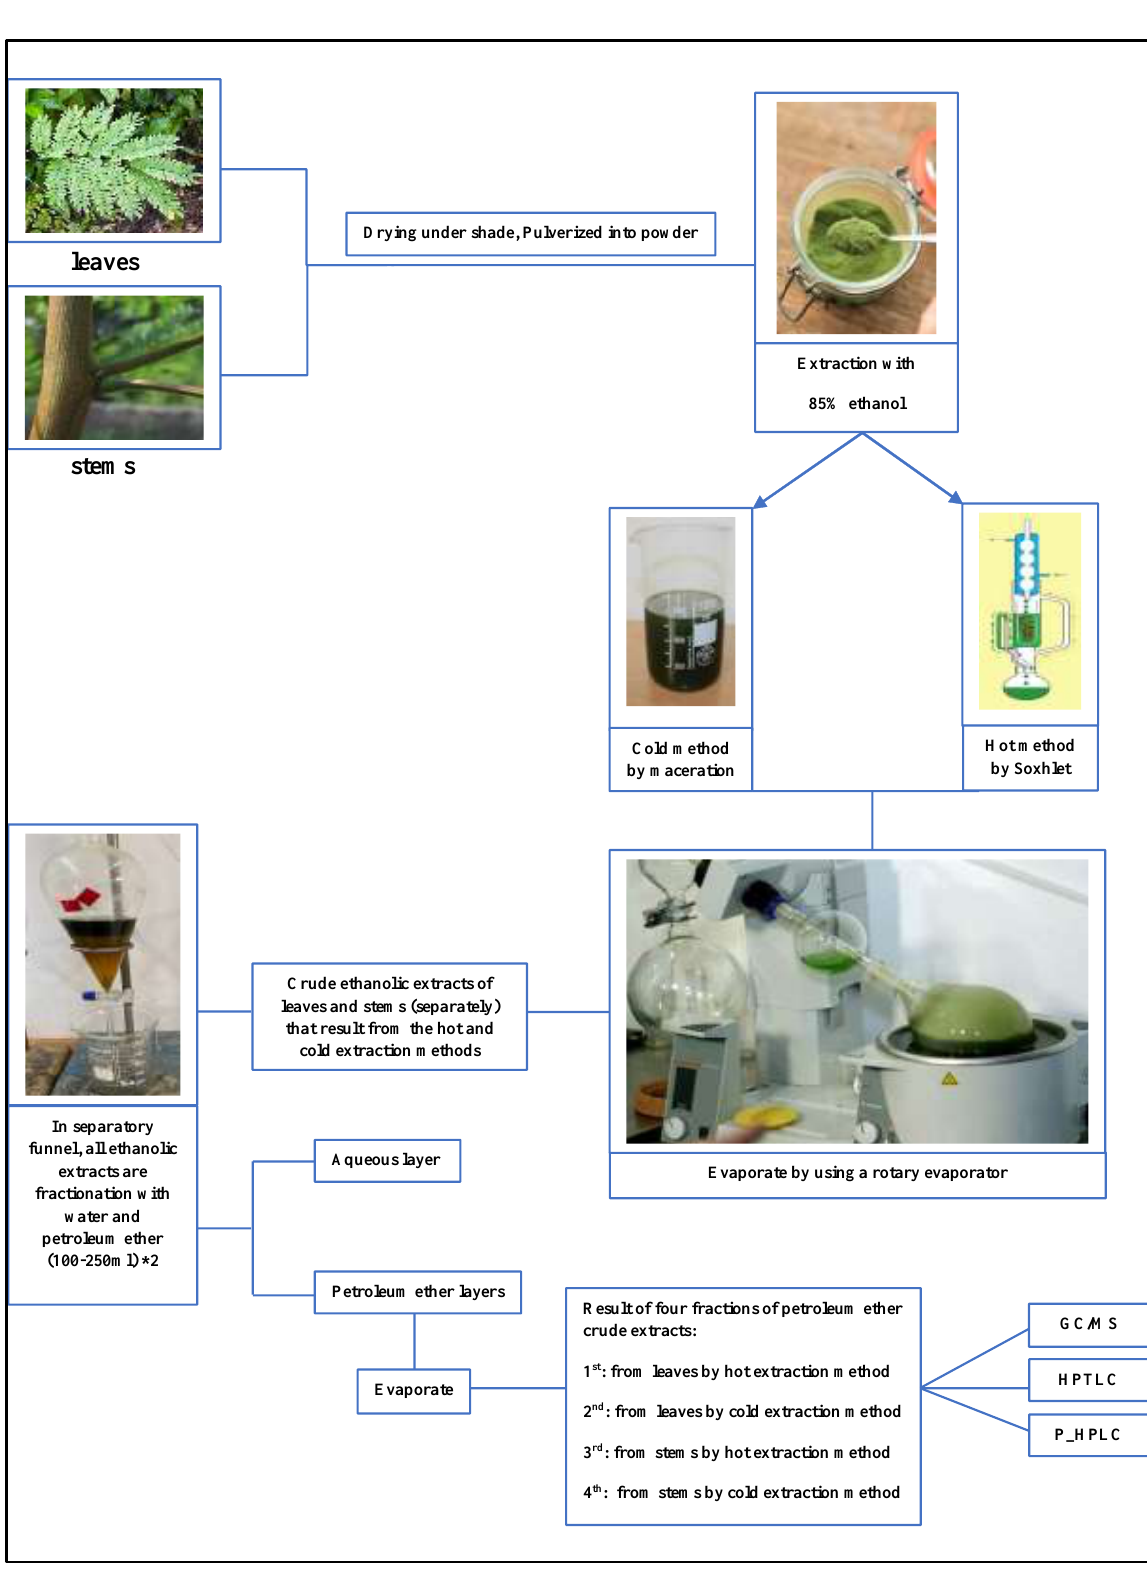
Figure 2. Extraction, fractionation & identification scheme of lupeol from Iraqi Leucaena